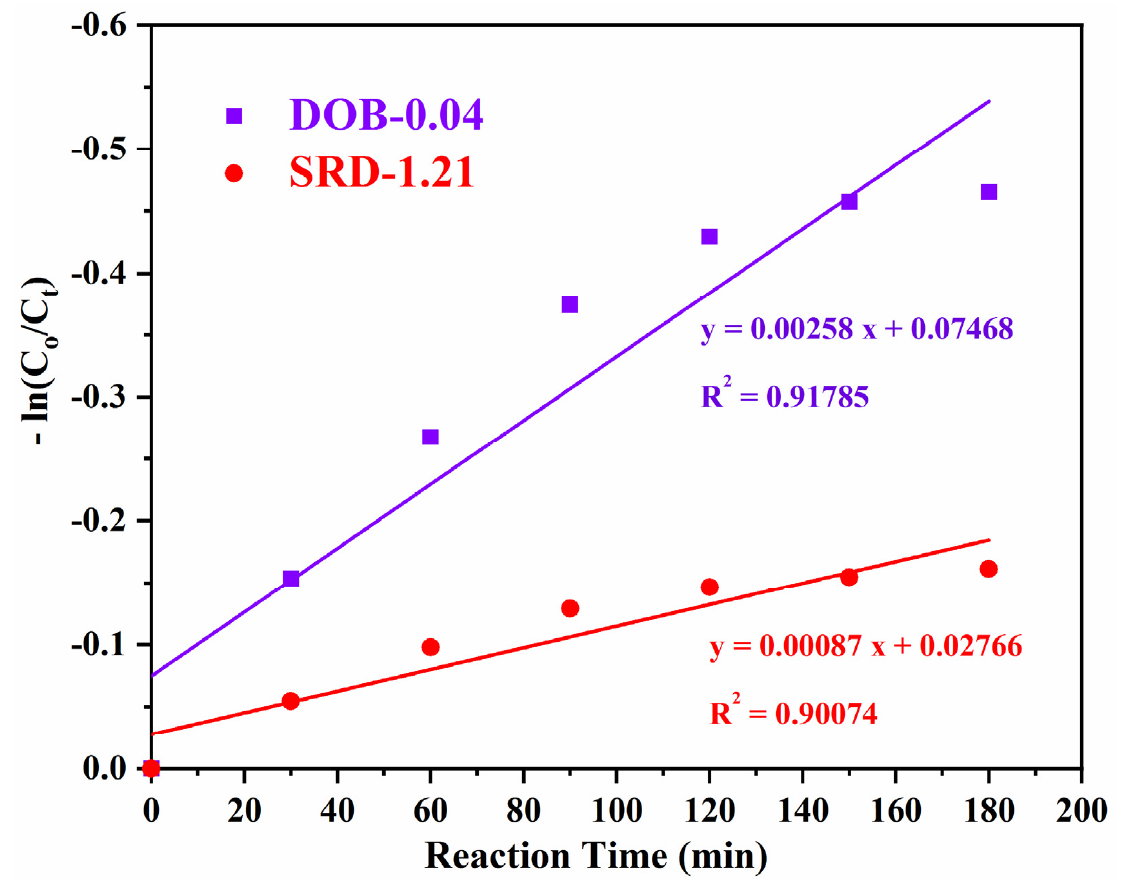
Figure 5. The pseudo-first-order kinetic fit for desulfurization diesel streams.